Question: What style of plot is this figure drawn as?
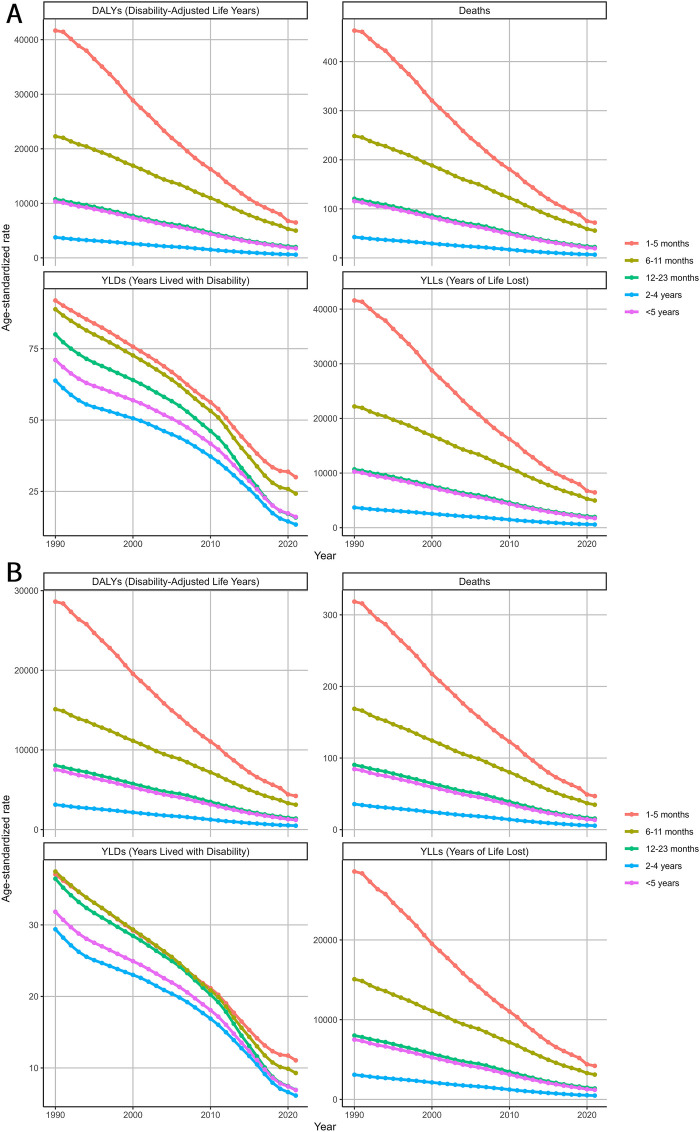
Answer: line